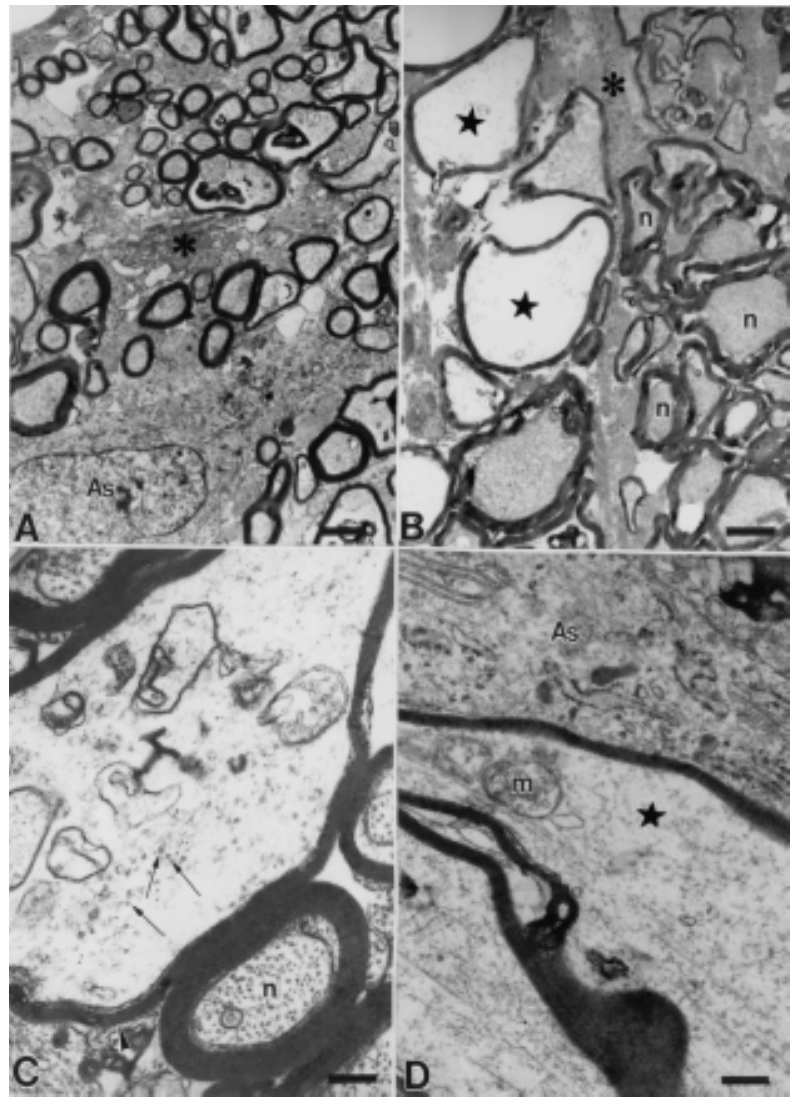
Fig. 2–Electronmicrographsofopossum’sopticnervefibersundergoingWalleriandegeneration, 72hoursaftercrush. A. Generalview of the optic nerve. Note the profuse astrocytic septa (asterisk) causing a severe disorganization of the optic fibers. Many fibers have an apparently normal appearance in this field. As, astrocyte nucleus. Bar = 1 . 7 µ m. B. Optic nerve fibers exhibiting an apparently normal axoplasm (n), but there is some distortion of their myelin sheath. We can also observe a fascicle in which fibers are undergoing watery degeneration (stars) and show increased volume with no discernible organelle in the axoplasm. Asterisk, astrocytic processes. Bar = 1 . 7 µ m. C. Optic nerve fiber showing reduction of axoplasmic content associated with presence of altered membranous organelles. Few microtubules (small arrows) can be seen in the axoplasm. The myelin sheath (arrowhead) is thin due to the increased axoplasmic volume, suggesting watery degeneration. Note a small-sized fiber (n) with an apparently normal appearance. Bar = 0 . 4 µ m. D. Longitudinal section of optic nerve fibers showing areas of focal degeneration represented by rarefaction of the cytoskeleton (star). Some components of the cytoskeleton can still be seen in the axoplasm. An astrocytic soma (As) is also seen. m, mitochondrial profile. Bar = 0 . 6 µ